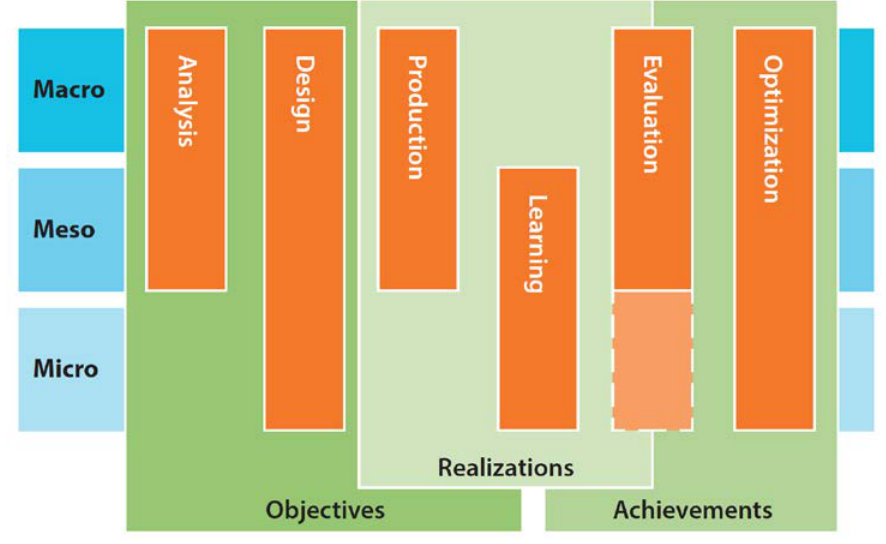
Figure 6 . Processes at macro, meso, and micro level in Open